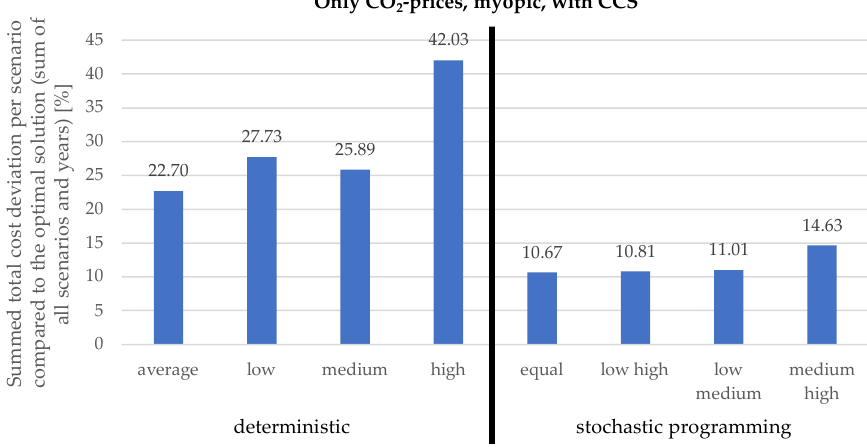
Figure 8. STCD per scenario for uncertain CO 2 prices (myopic, with CCS).